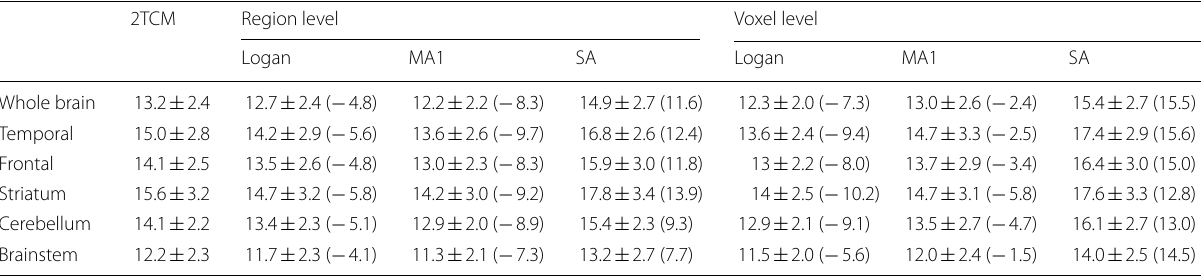
values obtained with different kinetic methods at region and voxel levels T